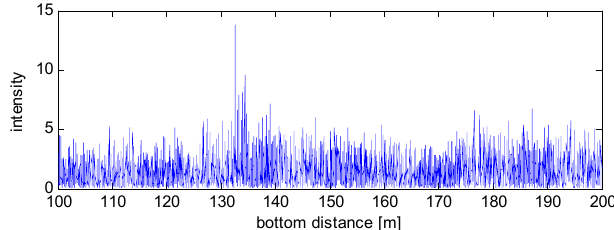
Figure 6. Matched filtering outputs when the time reversal technique is applied to the section with a